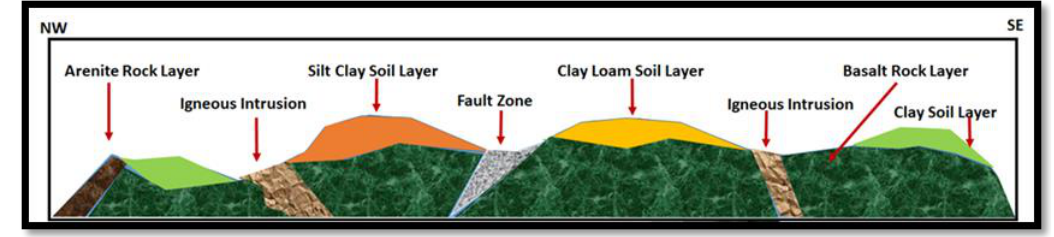
Figure 5. Cross-section view of the study area.